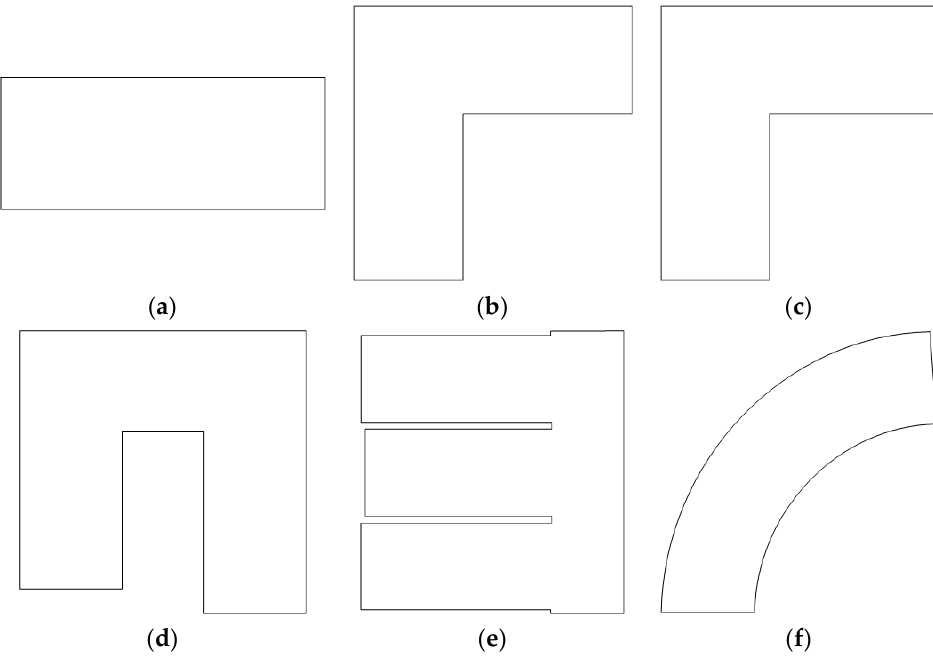
Figure 15. The extraction of boundaries for the evaluated stairs: ( a ) straight stair, ( b ) turn stair, ( c ) L-style stair, ( d ) n-style stair, ( e ) m-style stair, and ( f ) spiral stair. L-style stair, ( d ) n-style stair, ( e ) m-style stair, and ( f ) spiral